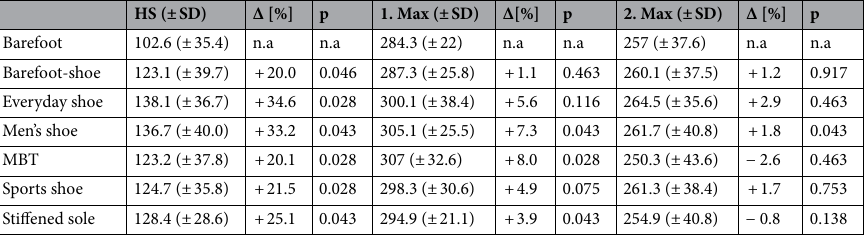
Table 2. Deltas [%] of the resultant contact force F res in relation to barefoot walking at 4 km/h; HS heel strike, SD standard deviation, MBT Masai-Barefoot-Technology.